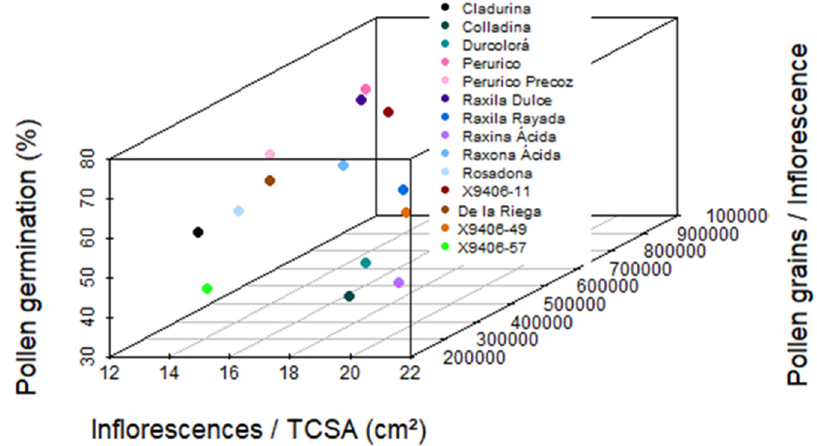
Figure 4. Three-dimensional scatterplot combining 3 variables (i.e., pollen germination (%), number of inflorescences/cm 2 of trunk cross-sectional area (TCSA)and number of pollen grains per inflo- rescence) for 14 apple cultivars in Villaviciosa (north-western Spain). The solid points stand for the means across the two-year data.